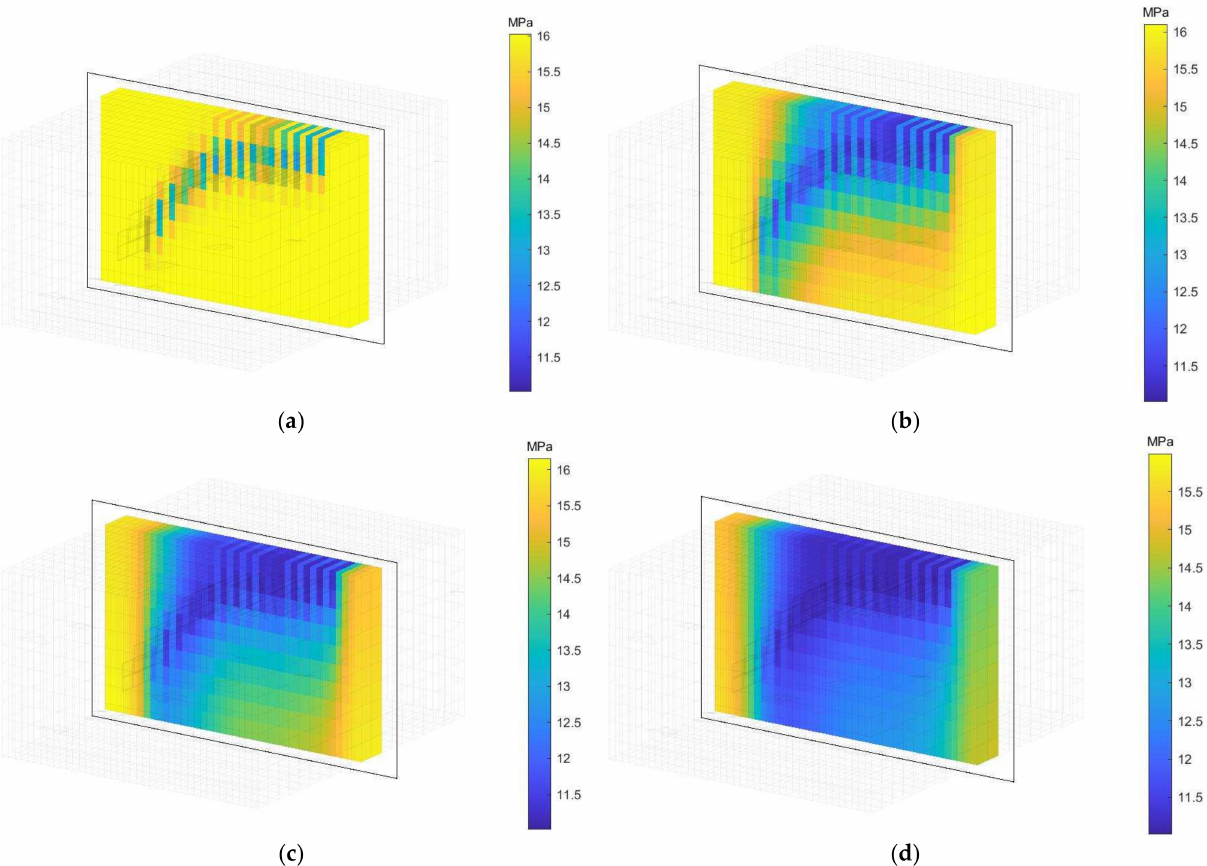
Figure 19. Static pressure of the reservoir in tilt-down case at production time ( a ) day 2, ( b ) day 30, ( c ) day 90, and ( d ) day